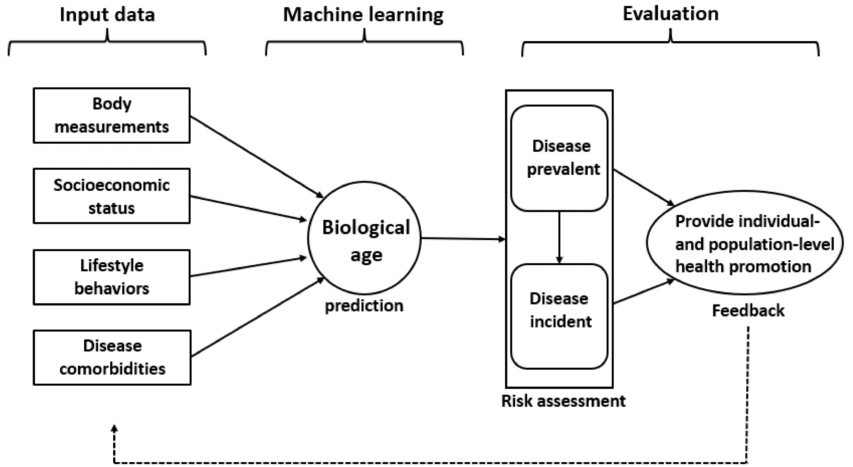
Figure 1. Architecture of development and evaluation of self-assessment of biological age for predict- ing the risk of chronic